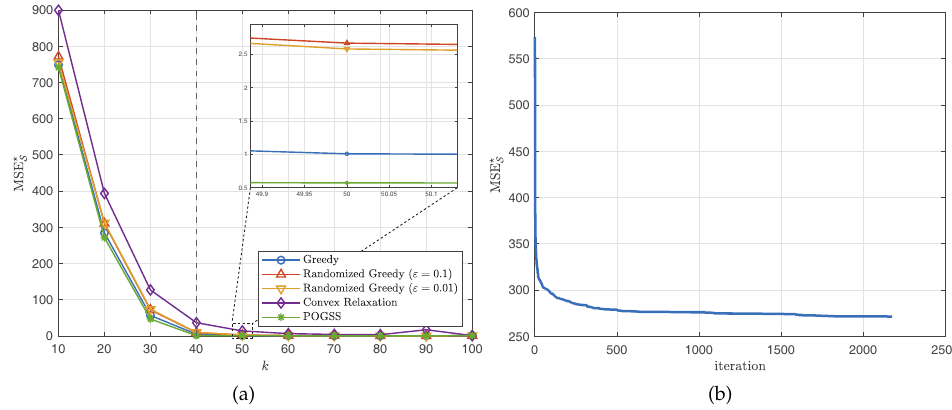
Figure 2. Results for bandlimited graph signals obtained on ER graphs. ( a ) MSE (cid:63) S v.s. k . ( b ) Conver- gence curve when k =